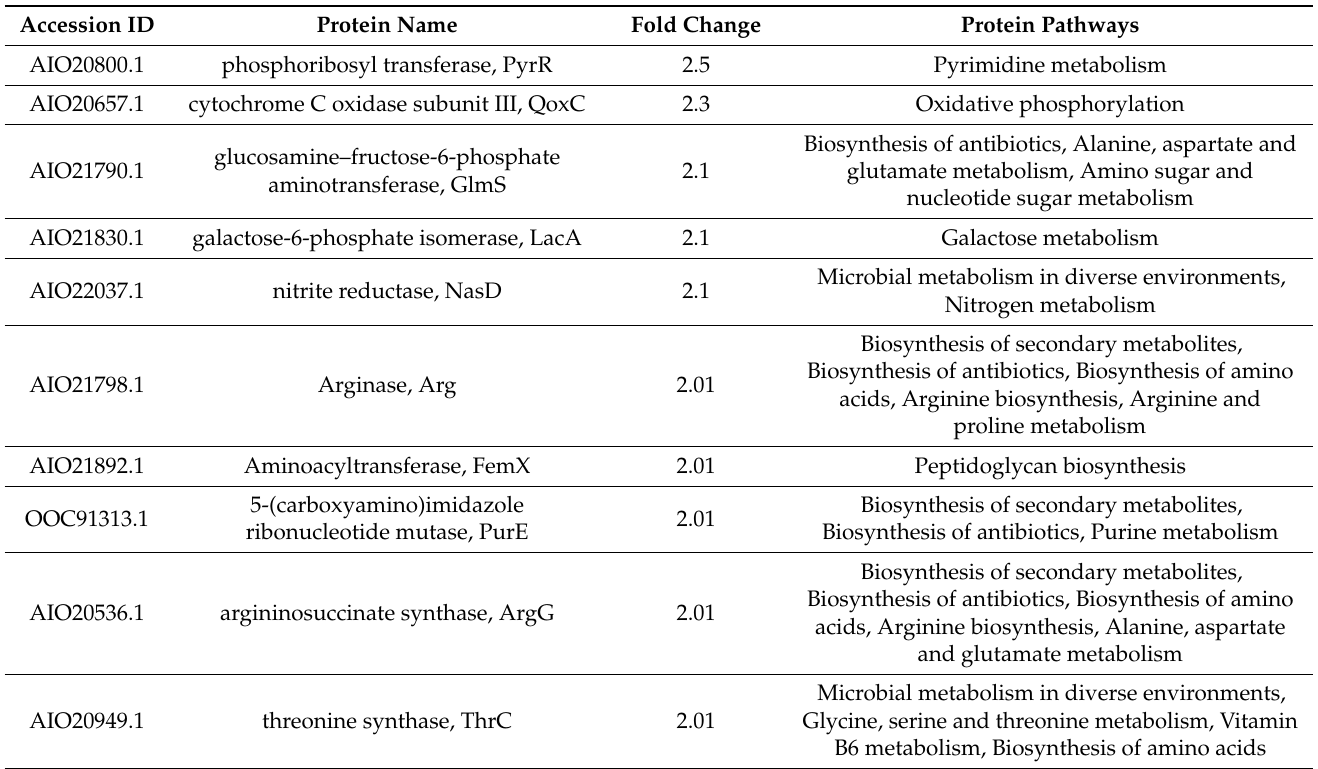
Table 1. Functional classification of the significantly upregulated proteins in hydrated biofilm in comparison to DSB ( p < 0.05).